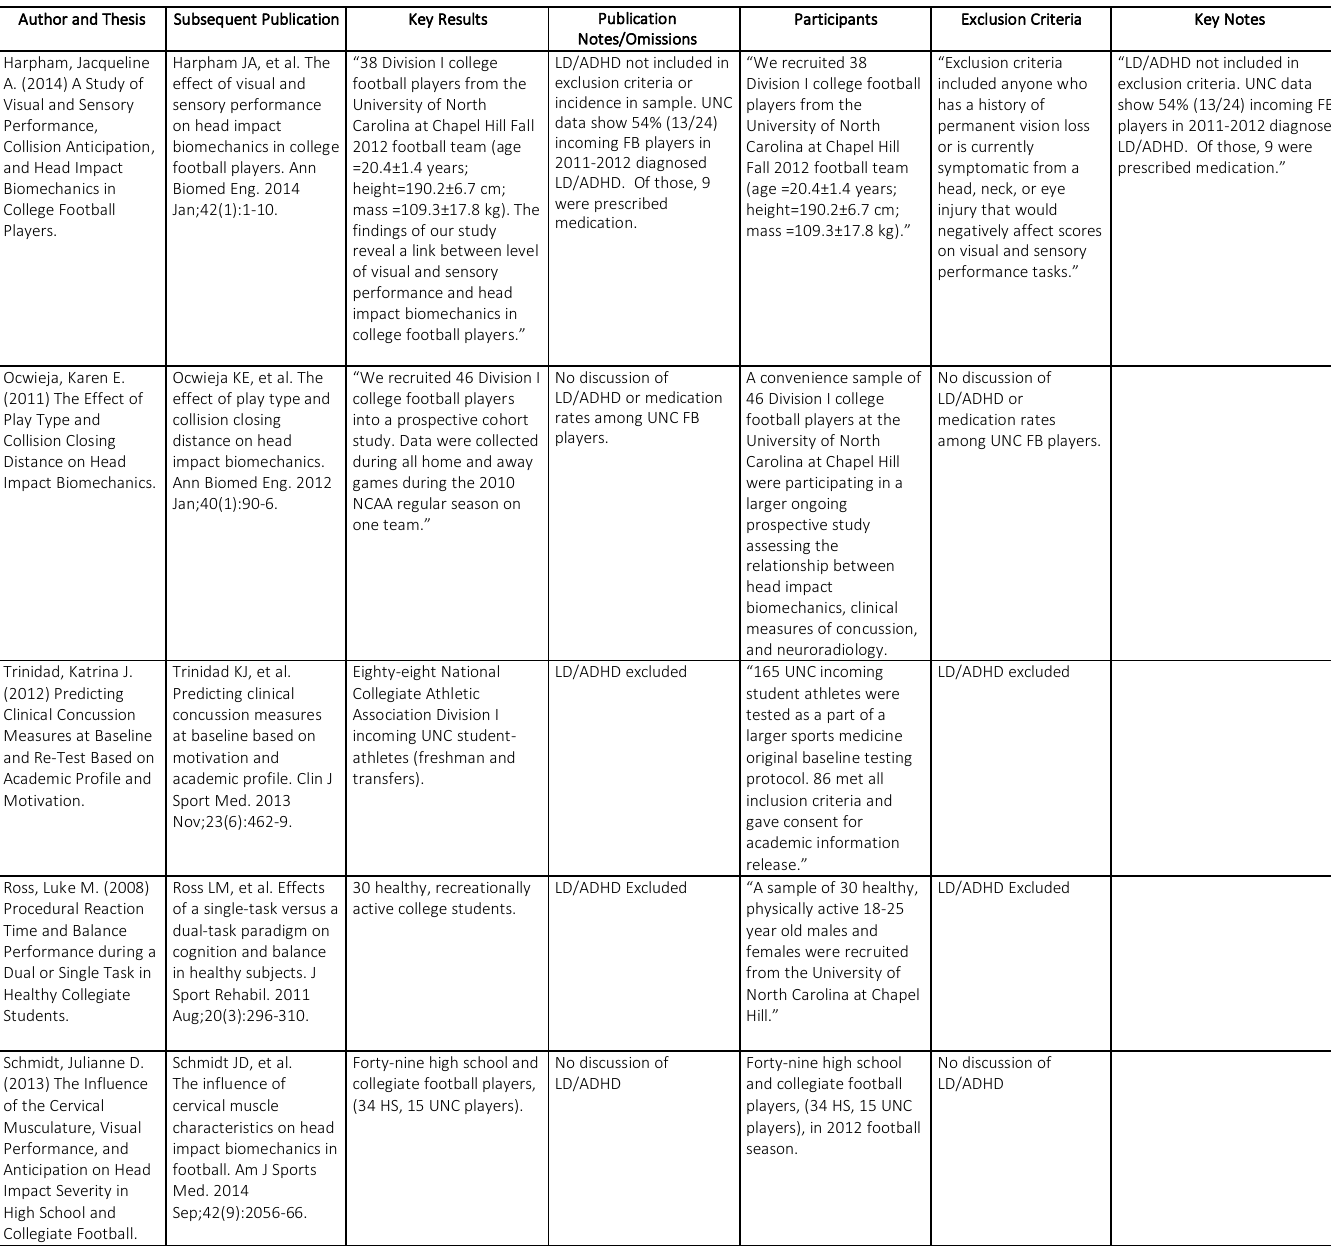
Table 5: Comparison of Theses and Resulting Published Articles